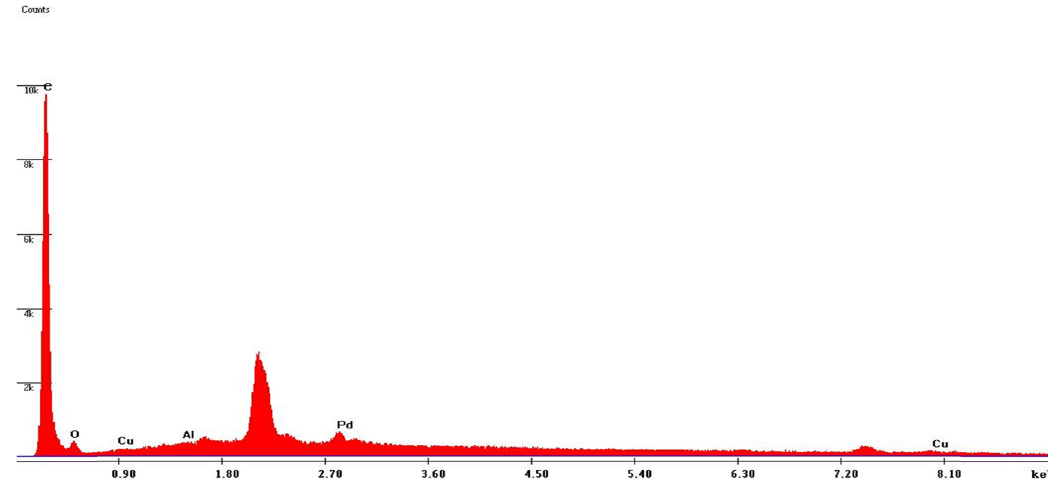
Figure 11: EDX pattern of 4Pd – 1Cu/AC.